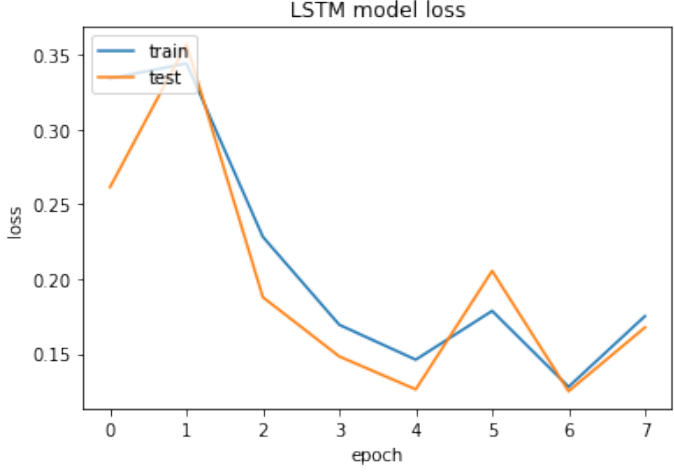
Figure 31. LSTM model